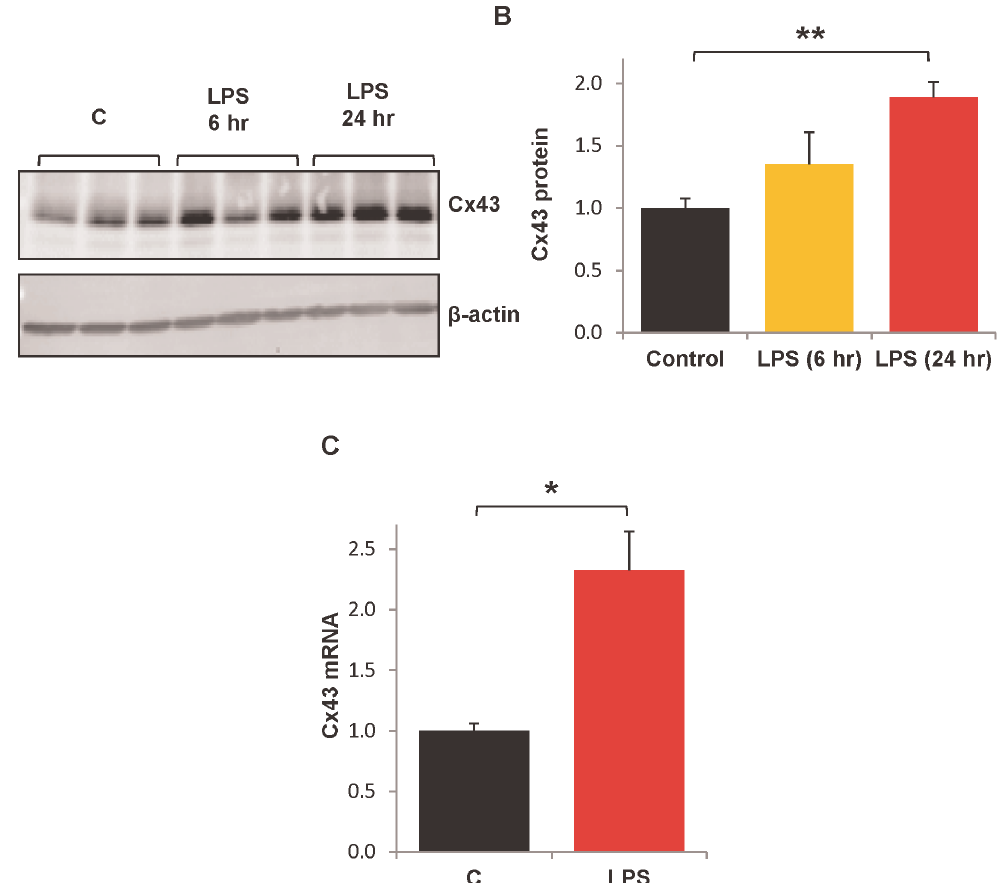
Figure 2. LPS increases Cx43 expression. HPAECs were treated with LPS (200 ng/mL) for 6 hr or 24 hr and collected for Western Blot or qRT-PCR analyses. A.) A representative Western blot is shown. B.) Cx43 protein expression was normalized to b -actin and expressed relative to control. **, p , 0.001. n=6 for control, n=3 for LPS (6 hr), n=7 for LPS (24 hr). C.) Real-time RT-PCR analysis was performed on cells treated with LPS (24 hr) or control cultures. Cx43 mRNA levels were normalized to GAPDH mRNA. *, p , 0.05, n=14.